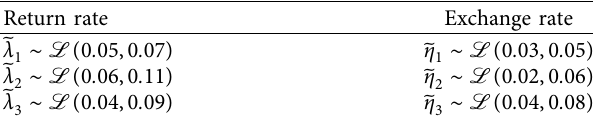
Table 3: The maximum